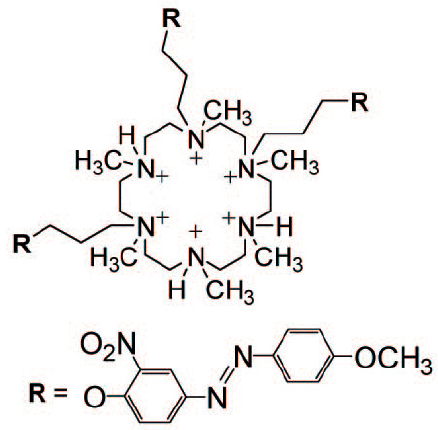
Figure 7. Chemical structure of azobenzene-tethered macrocyclic azacrown ether. Reprinted with permission from Ref. [76]. Copyright 2009 American Chemical Society.